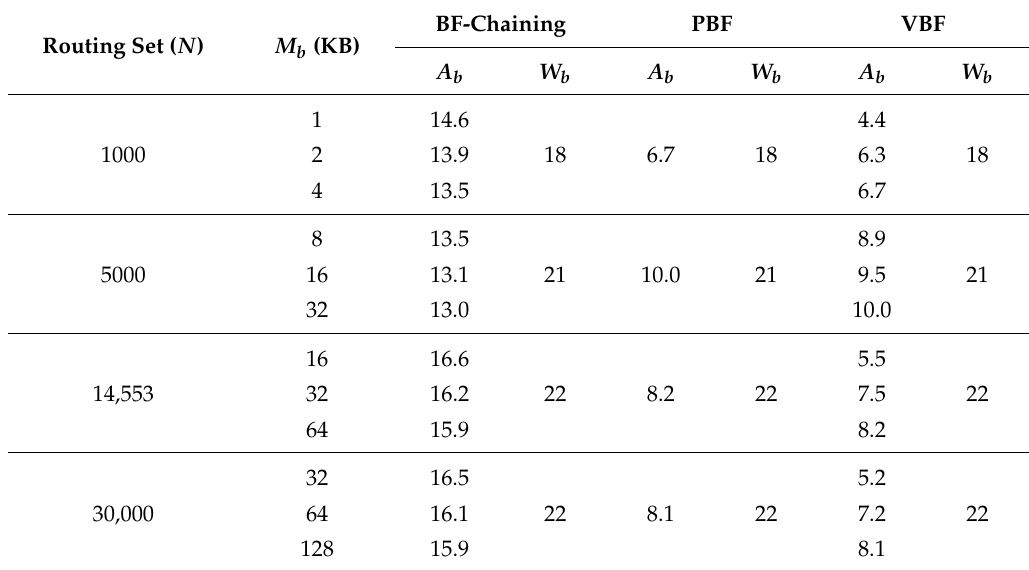
Table 6. Comparison on the number of on-chip Bloom filter querying.